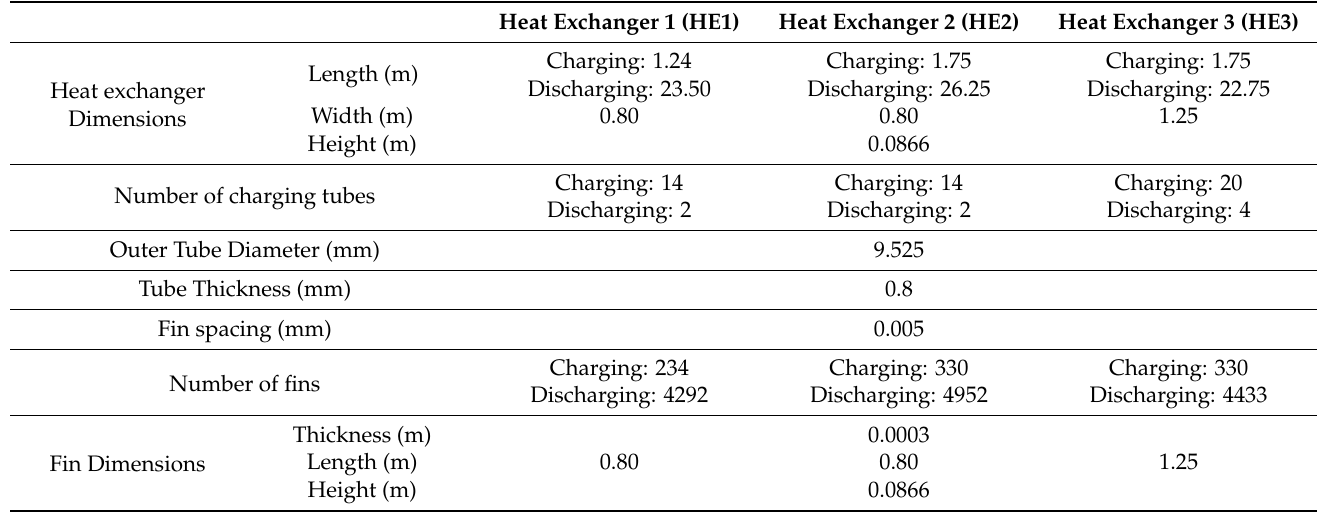
Table 2. Geometrical details of the HEs—Charging and Discharging